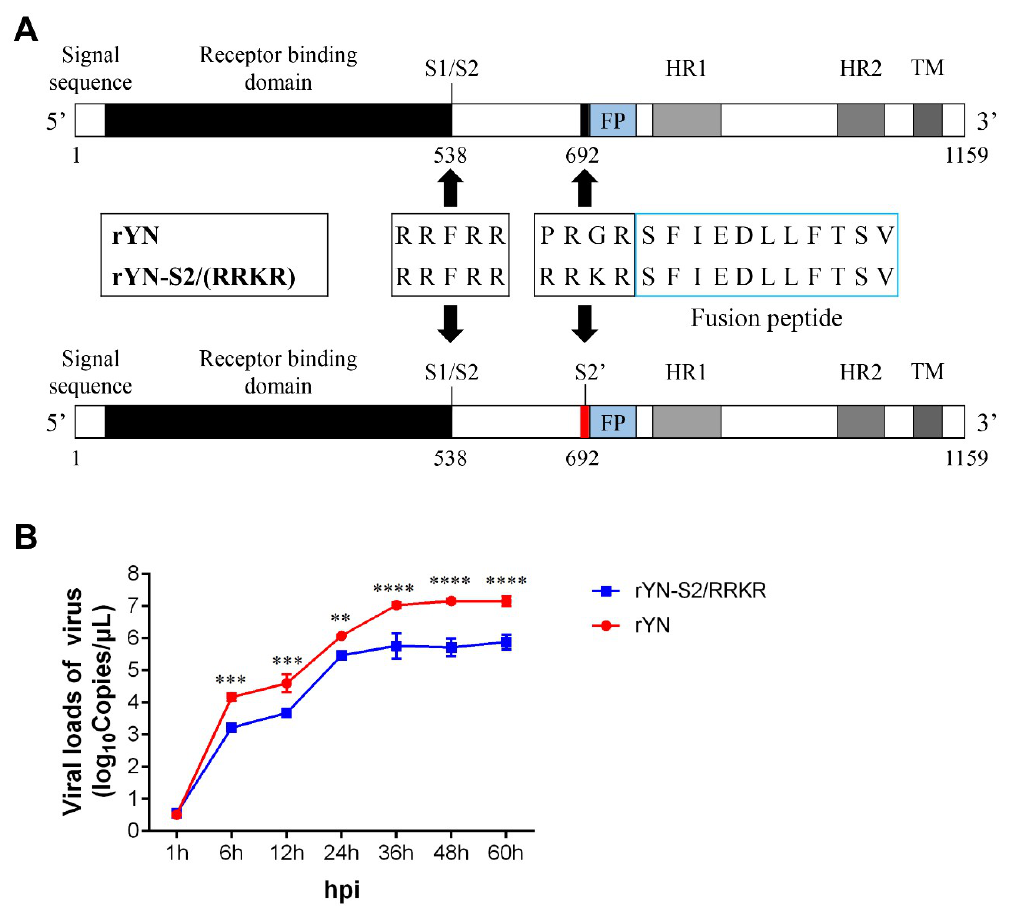
Figure 1. Introduction of a furin cleavage site upstream of the fusion peptide. ( A ) Schematic representation of the IBV spike protein. The original cleavage site at the S1 / S2 boundary and a furin cleavage site upstream of the FP are indicated by an arrow. ( B ) Growth curves of rYN and rYN-S2 / RRKR in CEK cells. Virus (10 3.0 EID 50 ) was inoculated in the CEK cells for 60 h. Viral loads were determined by measuring expression of the N gene in cell lysates using absolute RT-qPCR ( n = 3 × 3). Two-way ANOVA was used for analysis of di ff erences in GraphPad Prism 7.0 and the significance was considered as follows: highly significant at p < 0.01 (**), very highly significant at p < 0.001 (***) and extremely significant at p < 0.0001 Table 1. Time of death of embryonated eggs inoculated with rYN or rYN-S2/RRKR.